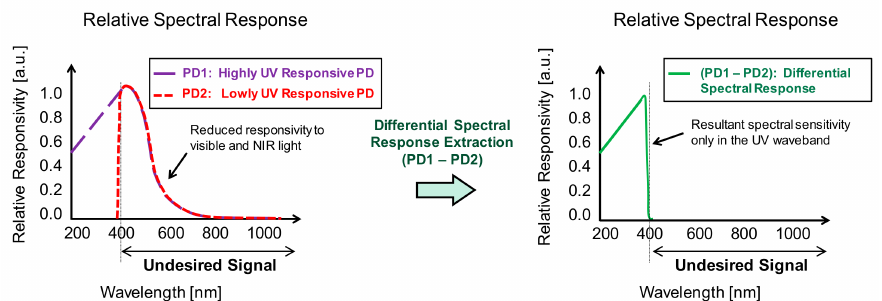
Figure 1. Conceptual diagram of the di ff erential spectral response UV sensor. High responsivity and high selectivity in the UV waveband are obtained by extracting the di ff erential response of the highly UV responsive photodiode PD1 and lowly UV responsive photodiode